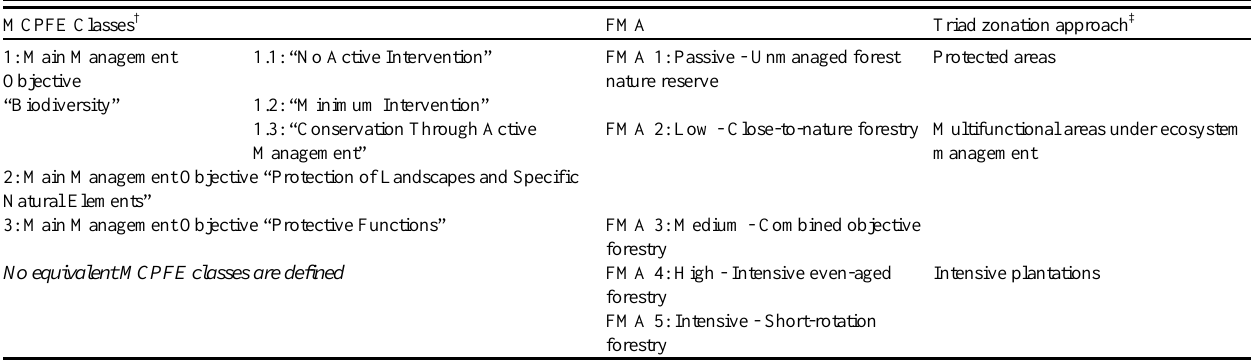
Table 3. Comparison of MCPFE classes of protected and protective forest and other wooded land in Europe, forest management approaches (FMAs), and separated forest areas according to the Triad zonation